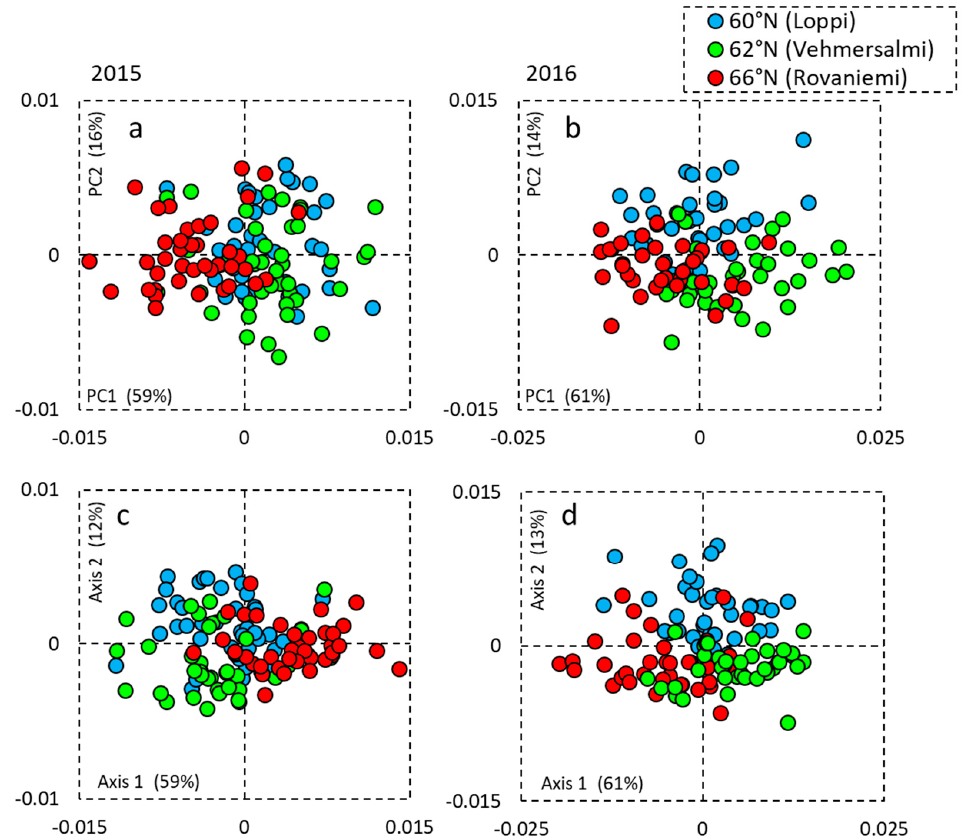
Figure 2. Data representation of provenance variation using the principal component analysis (PCA) ( a ) 2015 and ( b ) 2016 and PLS-DA ( c ) 2015 and ( d ) 2016. Each point (120 leaf samples in 2015 and 108 leaf samples in 2016) corresponds to a leaf sample and is colored according to the provenance: Loppi (L, 60° N, southern Finland), Vehmersalmi (V, 62° N, central Finland), and Rovaniemi (R, 66° N, northern Finland)).